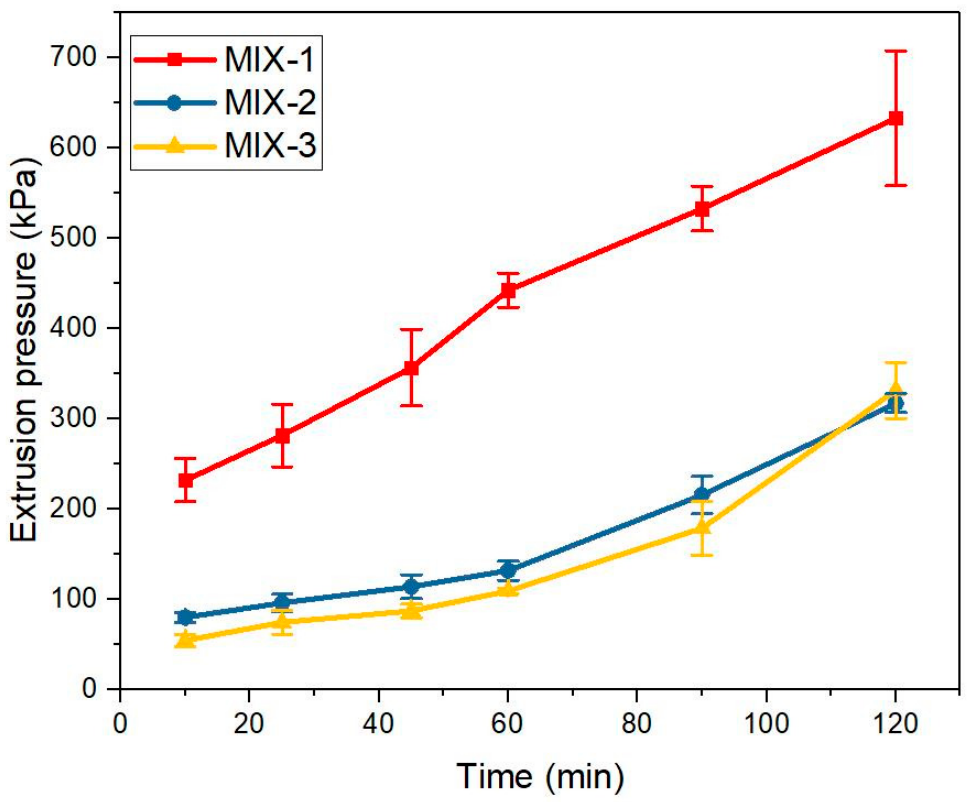
Figure 9. Comparison of the extrusion pressures (under 0.25 m / s of the piston moving speed) between mixtures MIX-1, MIX-2, and MIX-3 at the age of 10, 25, 45, 60, 90, and 120 min. The relative standard deviation (RSD) of the extrusion pressure is under 20%.